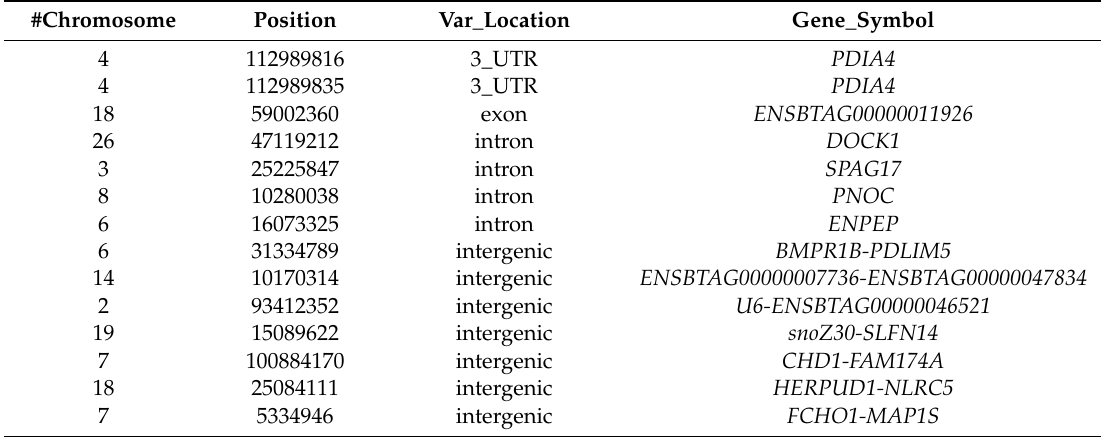
Table 4. Vc treatment rescued some deficient RNA-editing sites in cloned two-cell